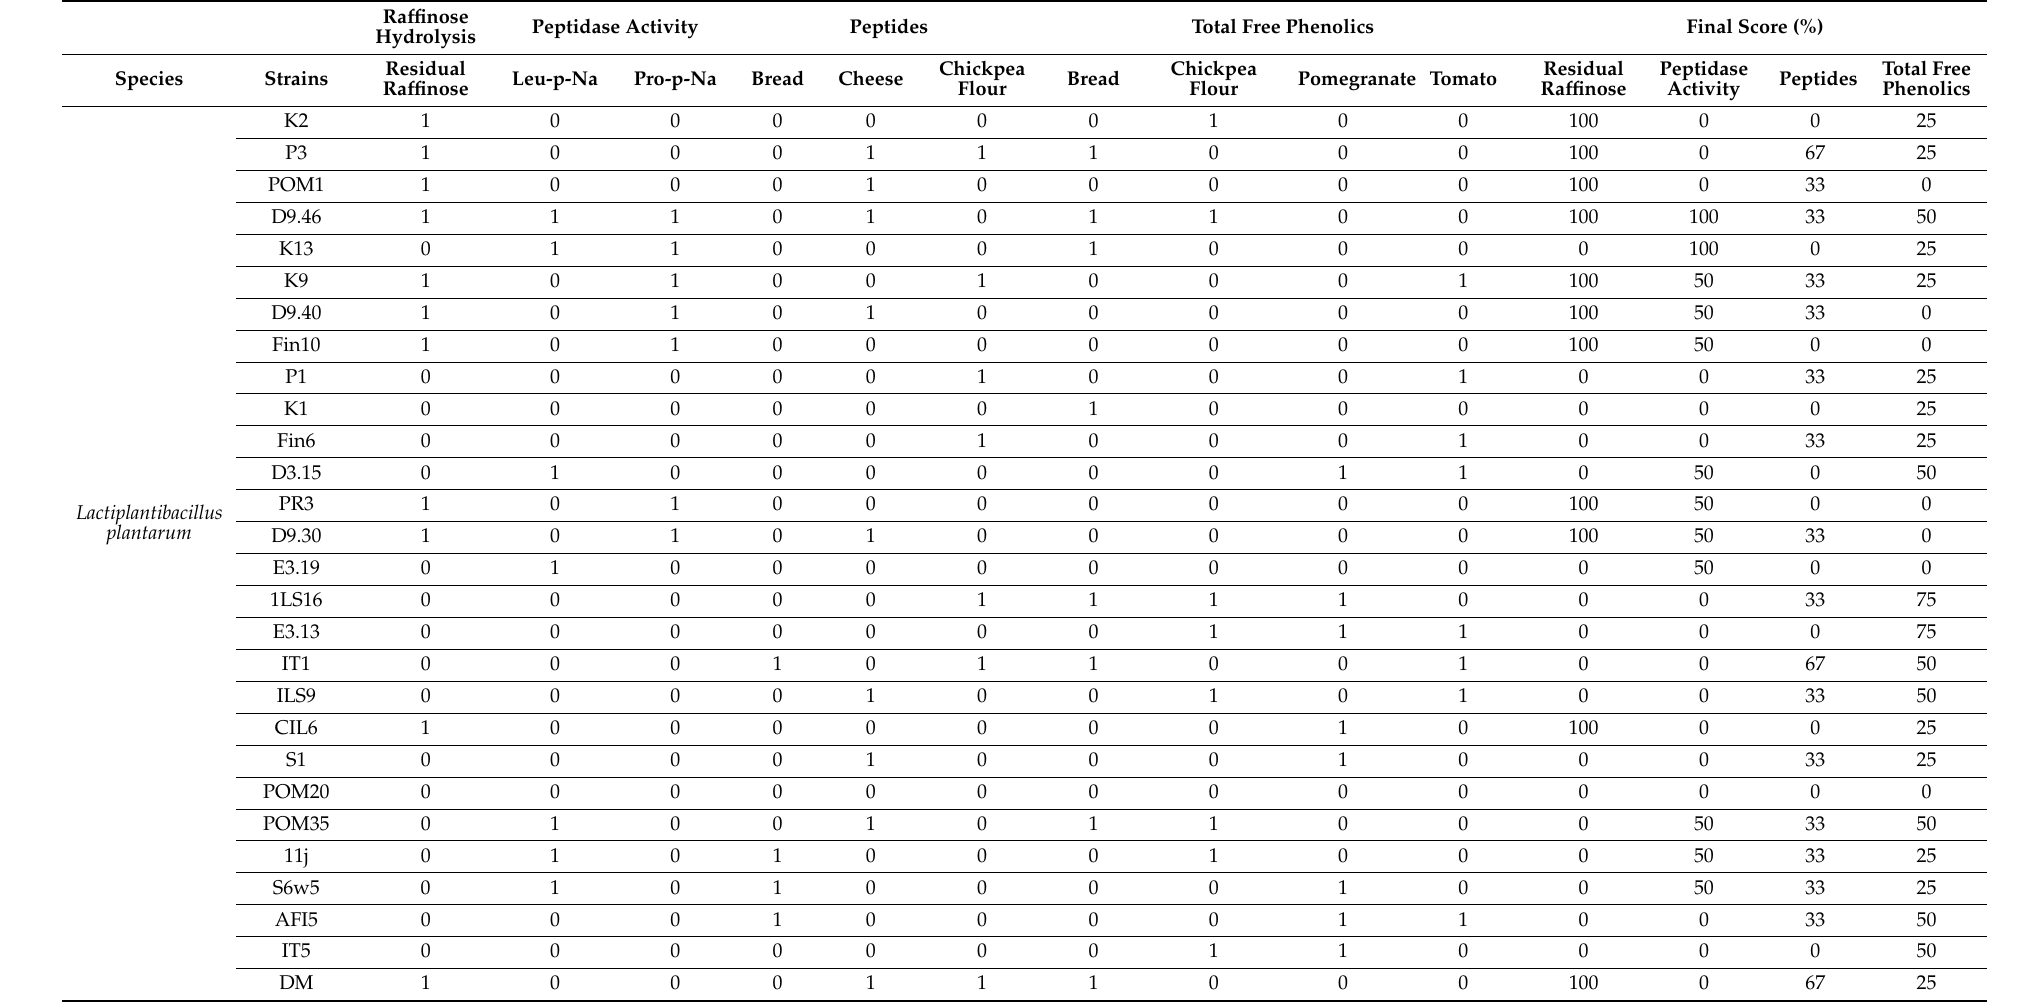
Table 1. Score evaluations (%) of 44 high-resistant lactic acid bacteria strains, belonging to different species and isolated from different sources, based on the results collected from the assays carried out in this